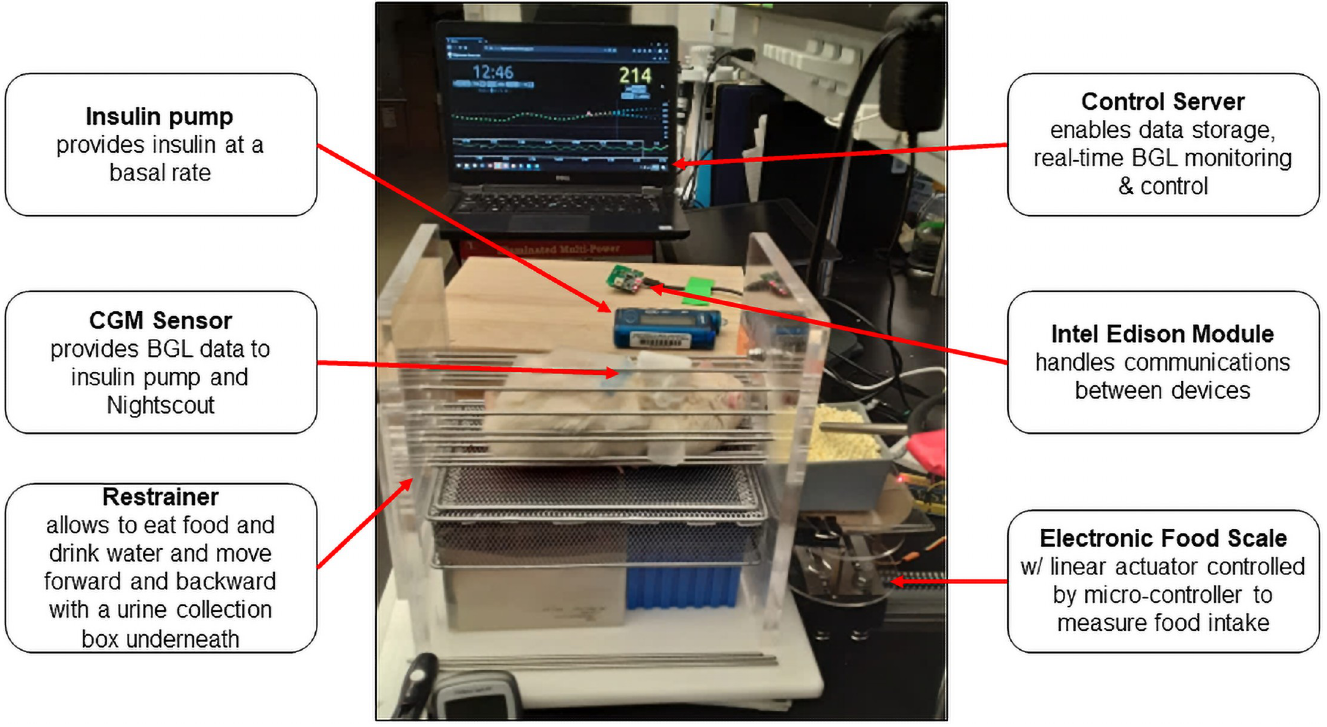
Fig 1. A photo image of a rat APS system. The rat APS system consists of an insulin pump, a CGM, an Intel Edison loaded with OpenAPS, a laptop as a control server, an electronic food scale, and a restrainer to hold a rat.